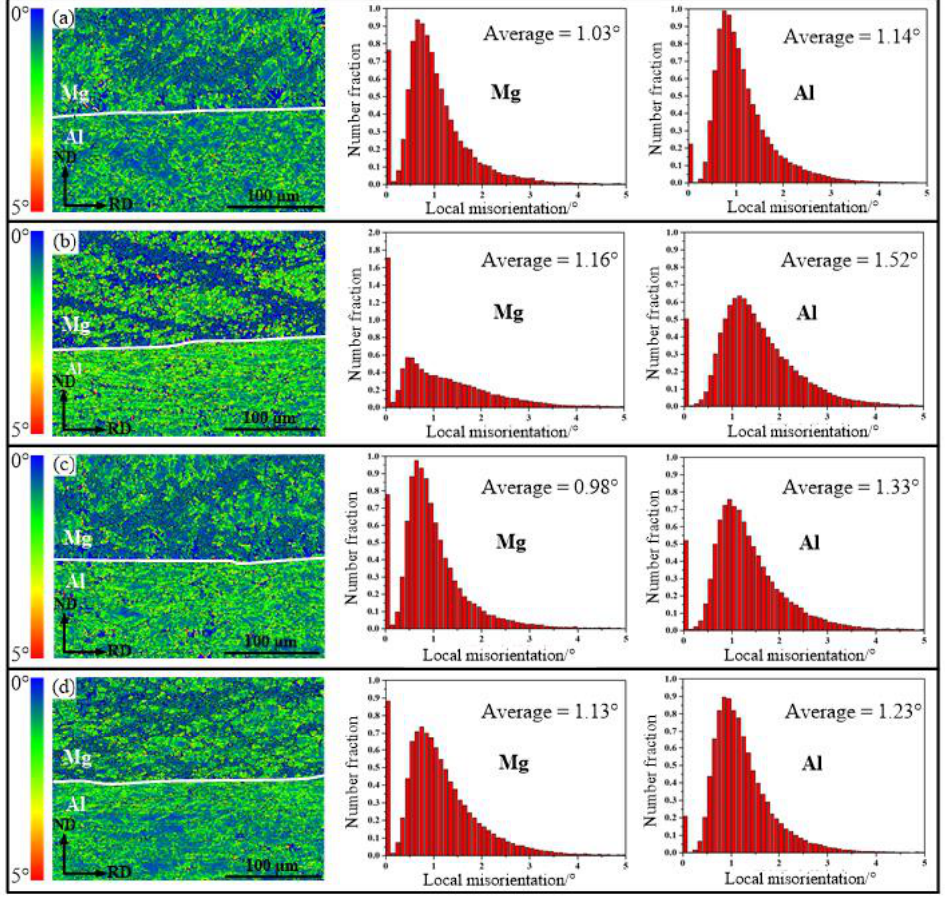
Figure 11. GND density distribution at four positions of the corrugated clad sheet: ( a – d ) Mg side; ( e – h ) Al side. In Figure 10, the Mg side contains blue grains, which belong to the low dislocation density region and were mainly caused by a dynamic recrystallization phenomenon. In addition, the high dislocation density was mainly distributed at the boundary of the de- formed grains, while the low dislocation density was mainly distributed inside the grains; this is due to the dislocation movement along the grain boundary when the grain bound- ary slipped. During the deformation process, a large number of dislocations proliferate and reproduce, which subsequently reach grain boundaries by slipping and climbing,